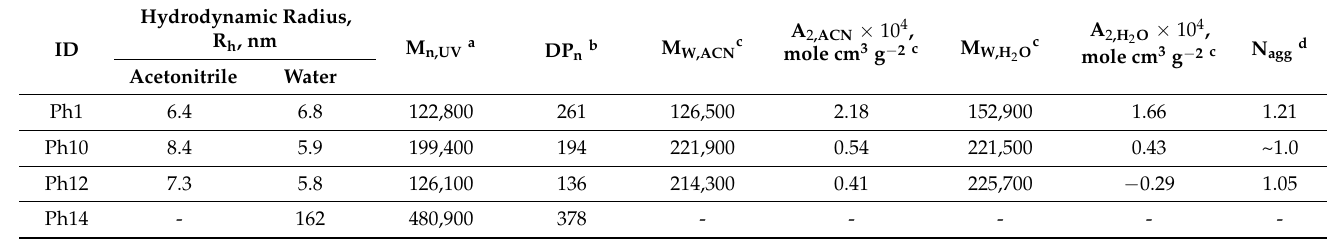
Table 2. Hydrodynamic and molecular weight characteristics of selected copolymers.